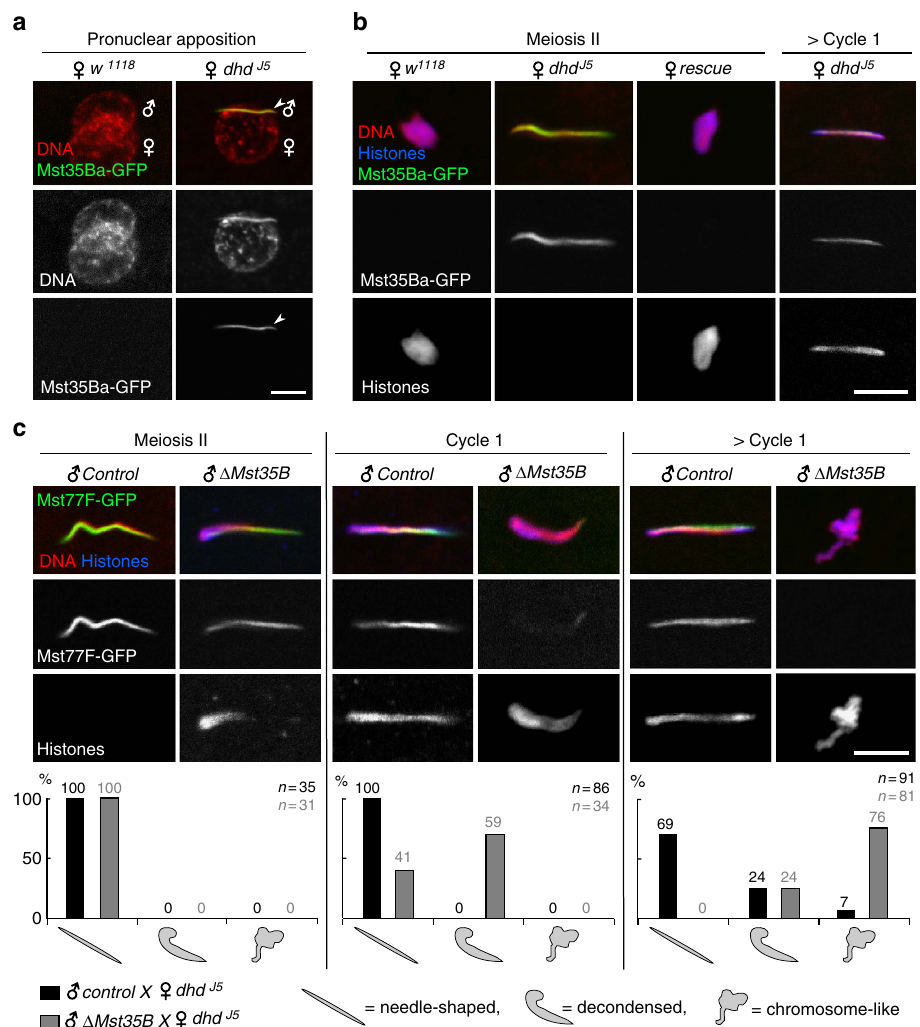
Figure 3 | DHD is required for the timely removal of SNBPs at fertilization. ( a ) Pronuclear apposition in eggs from control ( w 1118 ) or dhd J5 females mated with transgenic Mst35Ba-GFP males. The sperm nucleus (arrowhead) in dhd eggs still contains Mst35Ba-GFP (green). ( b ) Eggs or cycle 1 embryos from w 1118 , dhd J5 or dhd J5 ; P[dhd XhoI/XhoI ] (rescue) females mated with Mst35Ba-GFP males. The replacement of SNBPs with histones is severely delayed in dhd eggs and the phenotype is fully rescued by the genomic transgene. ( c ) Dynamics of SNBP/histone replacement in dhd eggs fertilized by control ( Mst77F-GFP ) or mutant ( D Mst35B ; Mst77F-GFP ) sperm. Distribution of phenotypic classes is shown for each stage. ‘ 4 Cycle 1’ indicates embryos with the polar body condensed into a rosette of chromosomes. Scale bars, 5 m